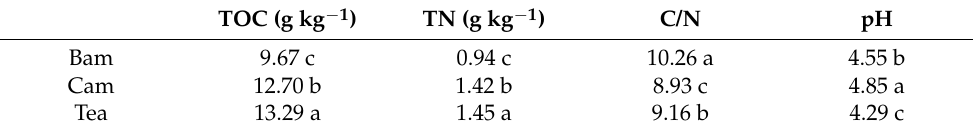
Table 1. Basic properties of soils from bamboo (Bam), camphor (Cam), and tea (Tea)